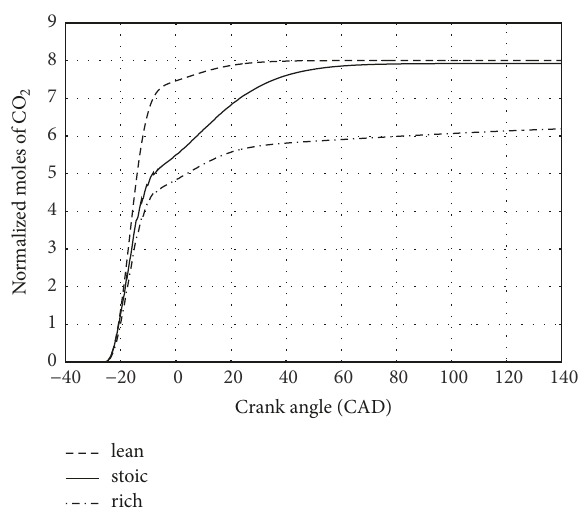
Figure 5: Variation of normalized moles of CO 2 with crank angle.